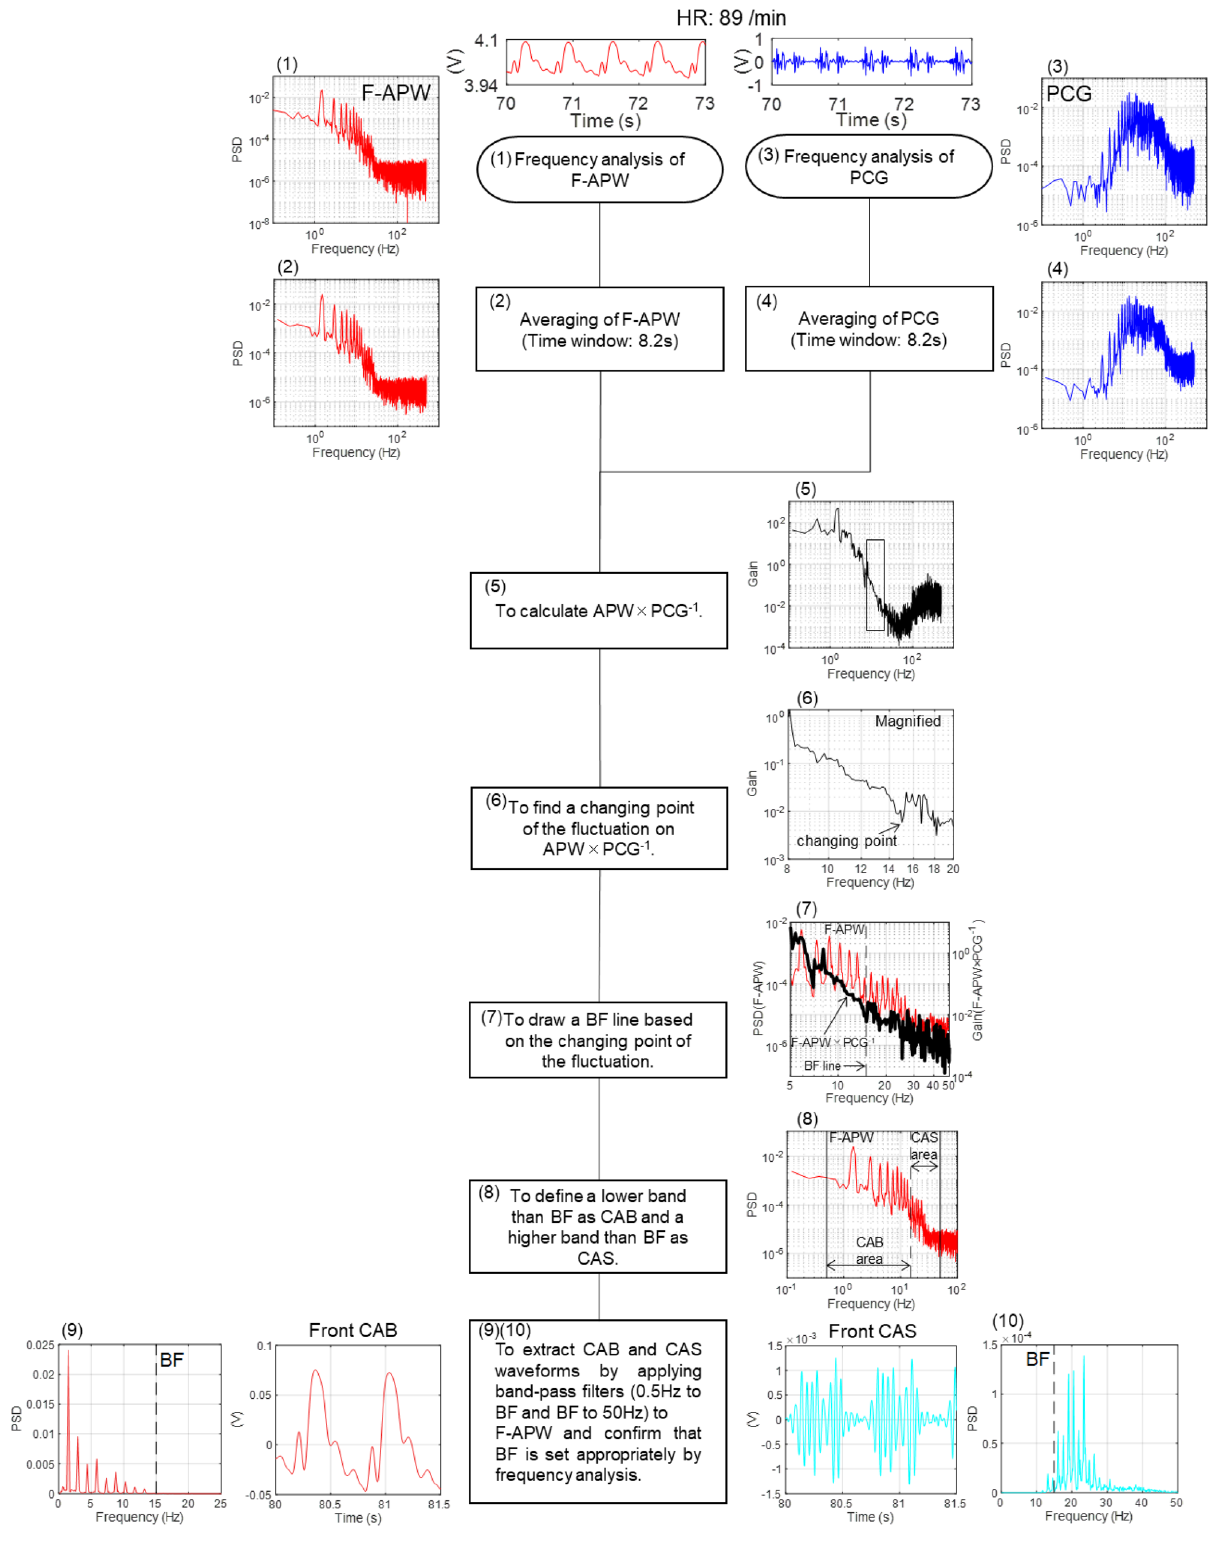
Figure 7. Flow chart: the way to compute BF.A flow chart to estimate BF by obtaining F-APW × PCG −1 from F-APW and PCG. Front CAB and Front CAS waveforms can be extracted from F-APW using the obtained BF. While F-APW × PCG −1 indicates the frequency analysis result of F-APW divided by the frequency analysis result of PCG, it also means that the frequency analysis waveform of PCG subtracts from the frequency analysis waveform of F-APW on a logarithmic axis. A cliff part appears in the differential waveform shown in drawing (6) of Fig. 7, and is considered to be